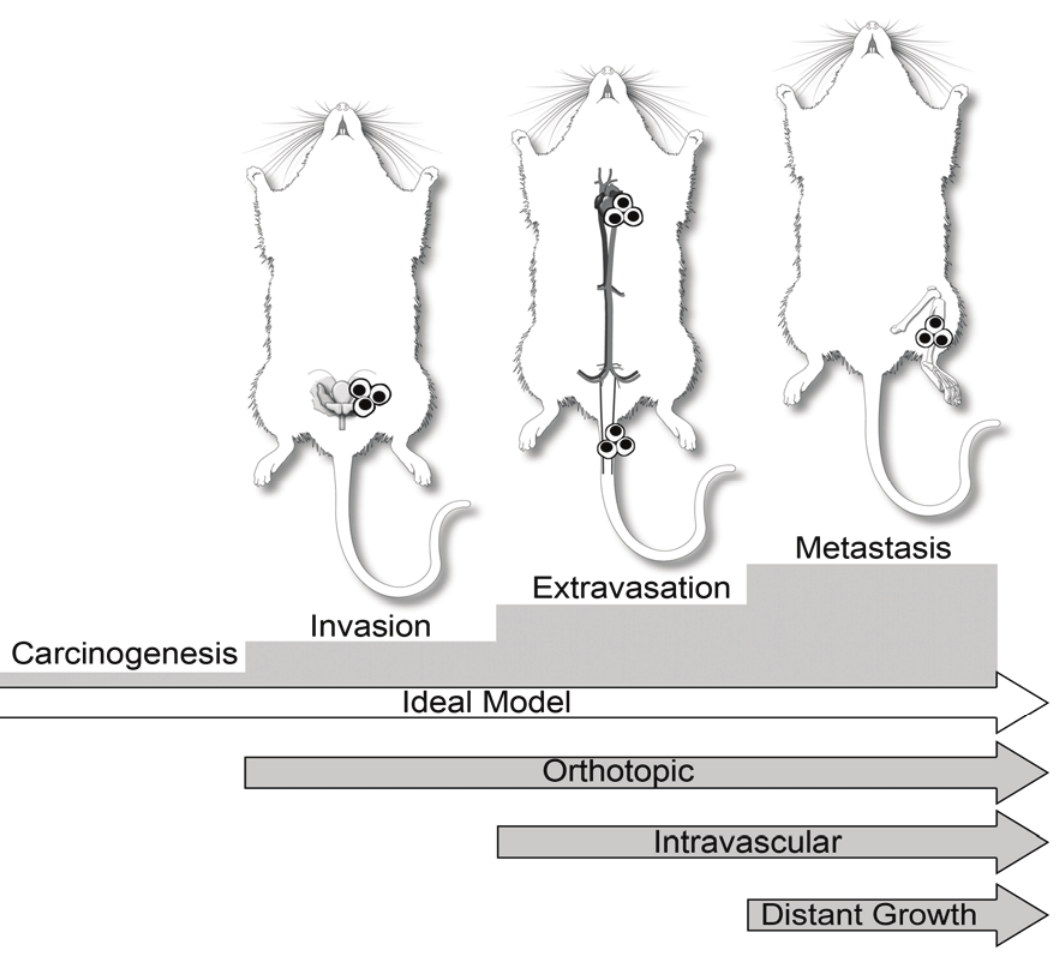
Figure 1. Different injection models of prostate cancer to investigate cancer progression and metastasis. The metastatic cascade involves the local invasion of tumor cells from the prostate, intravasation into a blood or lymph vessel, extravasation out of the circulation, and survival and growth at a secondary site (distant metastasis). At this time, metastasis models are not able to recapitulate this process from cancer initiation to metastatic disease. Therefore, different injection models are used to investigate this complex process. Prostatic (orthotopic) injections model invasion, extravasation, and distant metastasis. Intravascular injections (intracardiac, tail vein) model extravasation and metastasis. Tail vein injections tend to favor lung metastases, whereas intracardiac injection of cancer cells into the left ventricle permits cancer cells to localize to any tissue of the body depending on its inherent metastatic phenotype. Finally, intratibial injections model the ability to grow in and modify the bone microenvironment. Together, the different injection models reveal important information about the pathogenesis of the metastatic